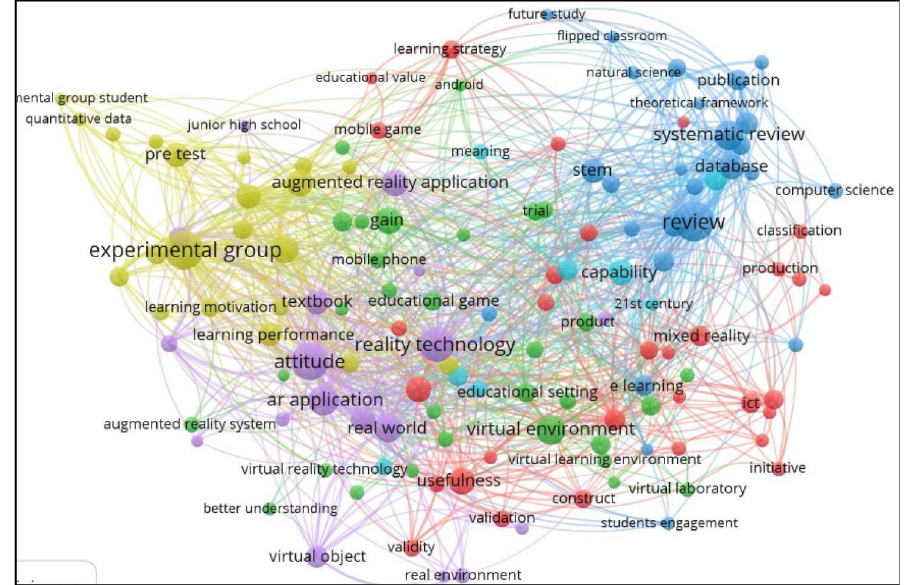
Figure 2. Research trends on augmented reality based on Scopus